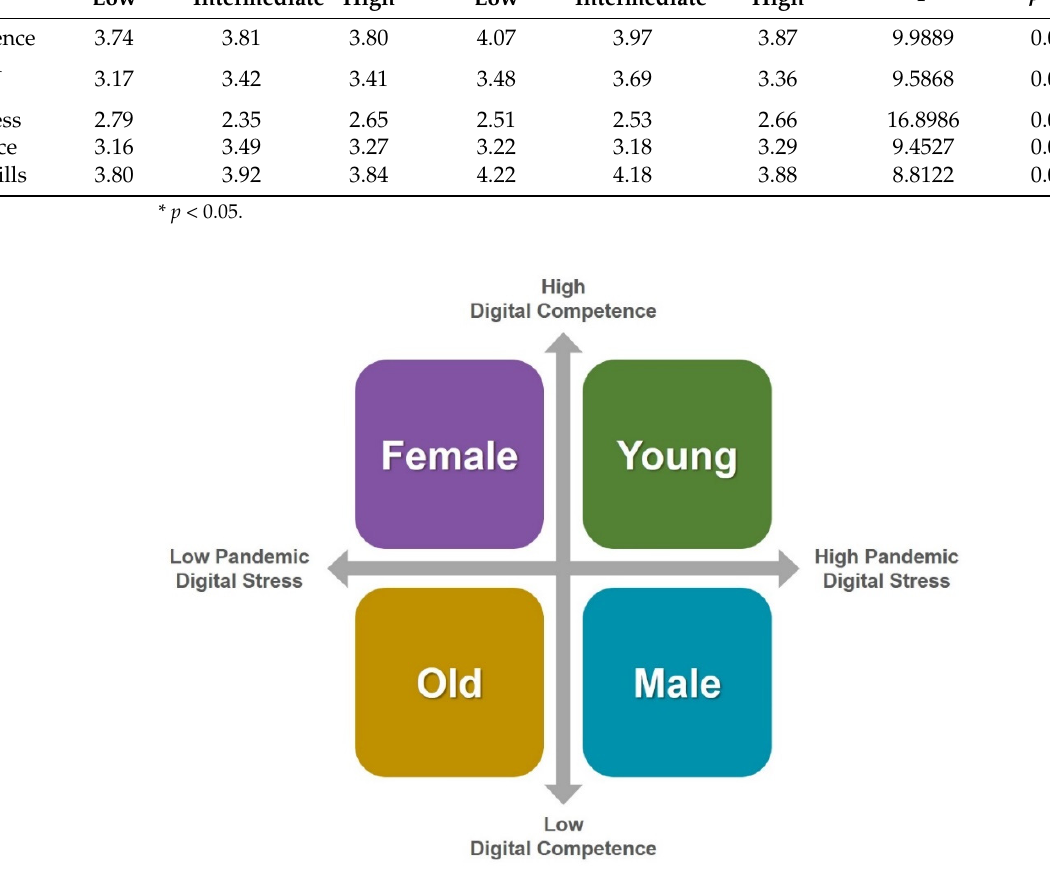
Figure 6. Grid of results on digital competence and digital pandemic stress by gender and age.